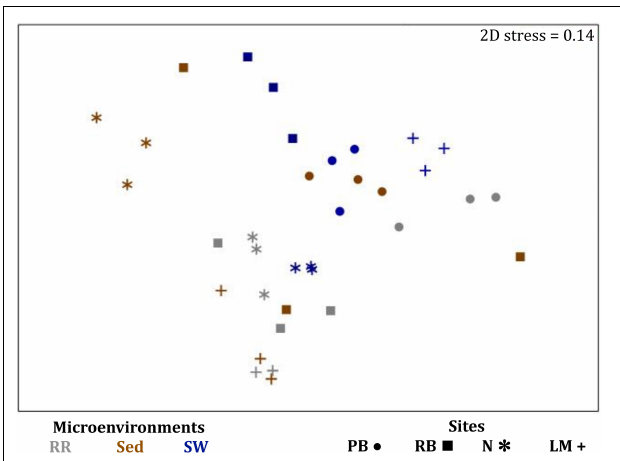
FIGURE 10 | Microenvironmental and regional partitioning of the seagrass fungal microbiome. Non-parametric multidimensional scaling (nMDS) of fungal microbiomes ( n = 35), based on a lower triangular resemblance calculated with the S17 Bray–Curtis similarity measure from relative abundances of OTUs (high values down-weighted with square root). Samples are colored by microenvironment (RR, roots and rhizomes; Sed, sediment, SW, seawater), with different shapes for sites (PB, Palm Beach; RB, Rose Bay; N, Narrabeen Lagoon; LM, Lake Macquarie). Sample clustering patterns by microenvironment within each site represent the level of similarity between samples based on the degree to which OTUs are shared between them. The 2D stress is shown in the upper right corner of the nMDS plot (Kruskal stress formula = 1, minimum stress = 0.01). The nMDS for the three microenvironments associated with the leaf is provided in Supplementary Figure 6 and a hierarchical cluster analysis (CLUSTER) is provided in Supplementary Figure 7